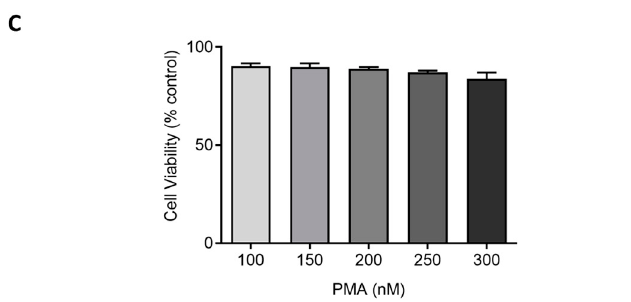
Figure 1. ( A ) Morphology of U-937 cells in the absence (a) and presence of 150 nM PMA for 48 h (b) and 72 h (c) post incubation at 37 °C. ( B , C ) Cell viability (%) of U-937 cells post incubation with DMPO and PMA at varying concentration. The data are represented as mean ± SE.